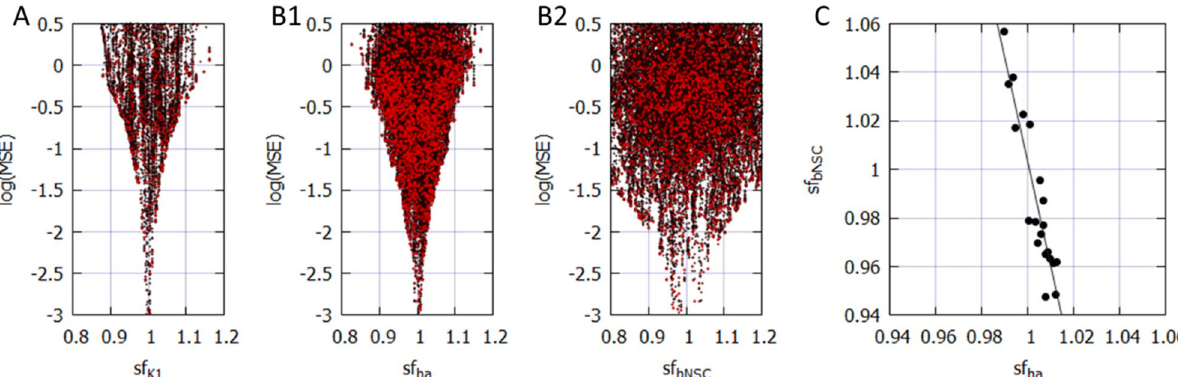
Figure 6. The complementary relations among sf K1 , sf ha and sf bNSC . ( A ) and (B) results of the multi-run orp test. A; the perfect convergence of sf K1 when sf ha and sf bNSC were fixed. ( B1 ) improved convergence of sf ha and ( B2 ) sf bNSC when sf K1 was fixed. In these two orp tests, sf x of other currents showed quite comparable convergence as in Fig. 4A. ( C ) the correlation between sf ha and sf bNSC